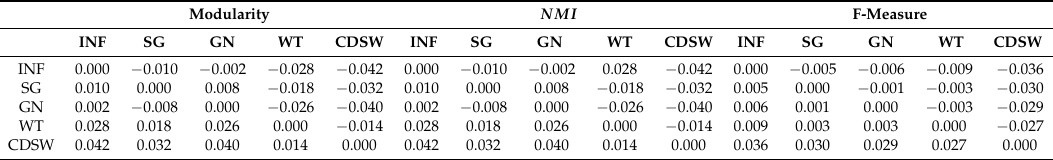
Table 4. Mean deviation in modularity, NMI and F-measure for different